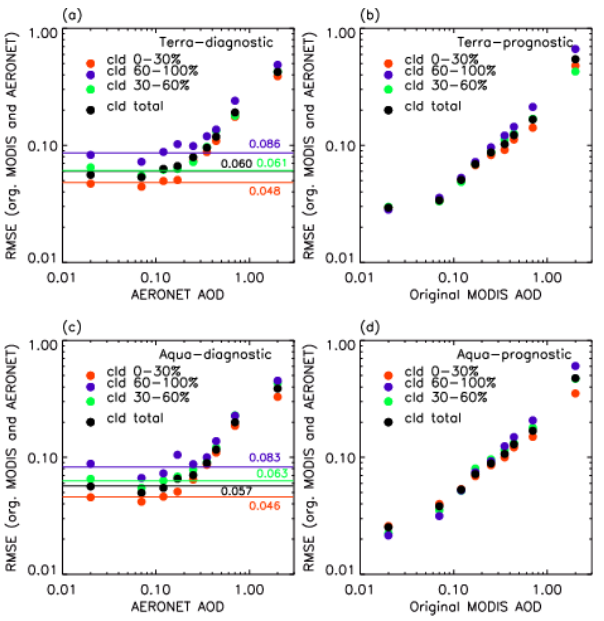
Fig. 8. RMSE of newly generated MODIS Terra and Aqua AOD comparing to AERONET AOD as a function of AERONET AOD and MODIS AOD. Data under different cloud fraction conditions are indicated with different colors. Red, green purple, and black represent data with cloud fraction between 0–30%, 30–60%, 60– 80%, and with total